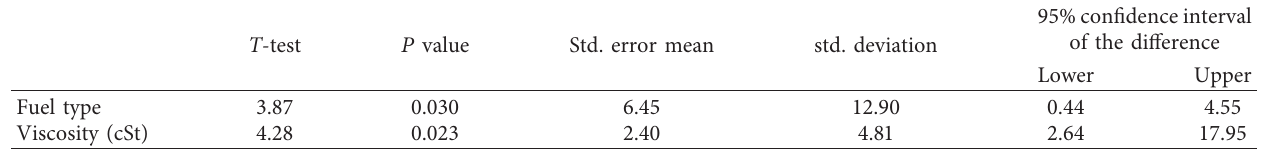
Table 4: Statistical test of the effect of blending on Jatropha oil viscosity.